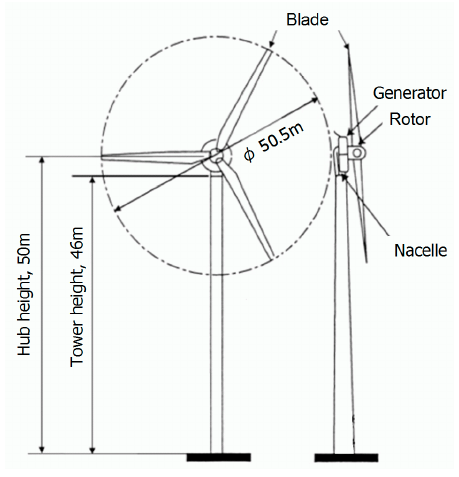
Figure 3. Schematic diagram of the wind turbine.